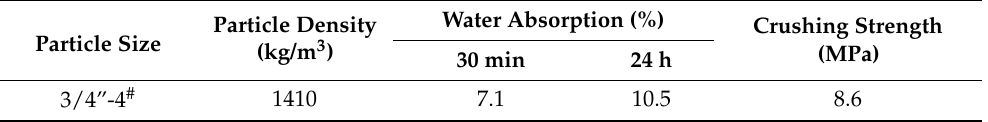
Table 3. Basic properties of the lightweight coarse aggregate used.